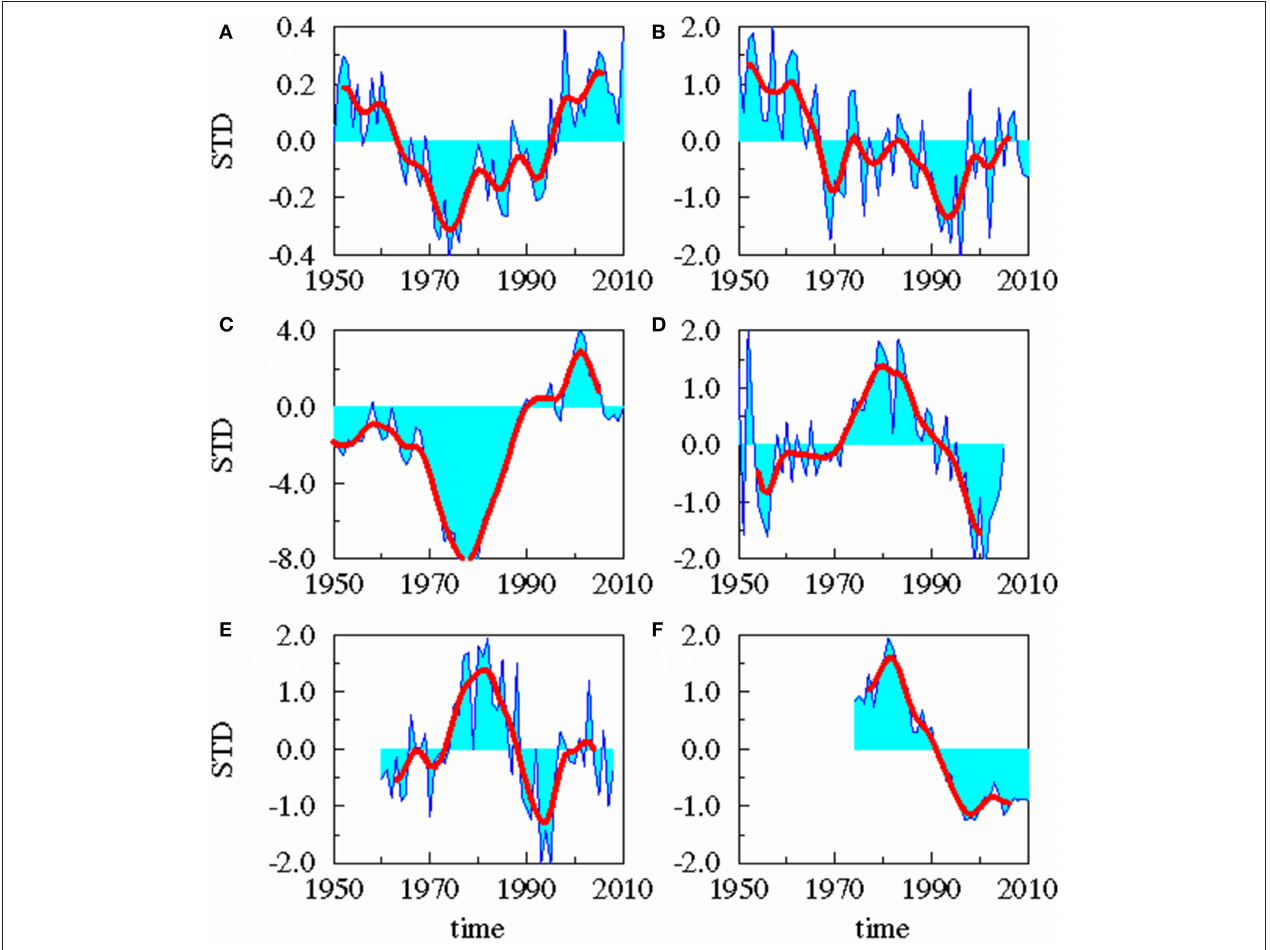
FIGURE 2 | Time series. Standardized yearly mean anomalies of AMO (A) , area averaged precipitation (B) , cumulative river runoff (C) , salinity in the upper 30m of the Gotland Sea (D) , zooplankton spring biomass of P. acuspes (E) , and mean weight of 3 years old herring (F) . The thick red line is low-pass filtered with a cut off period of 10